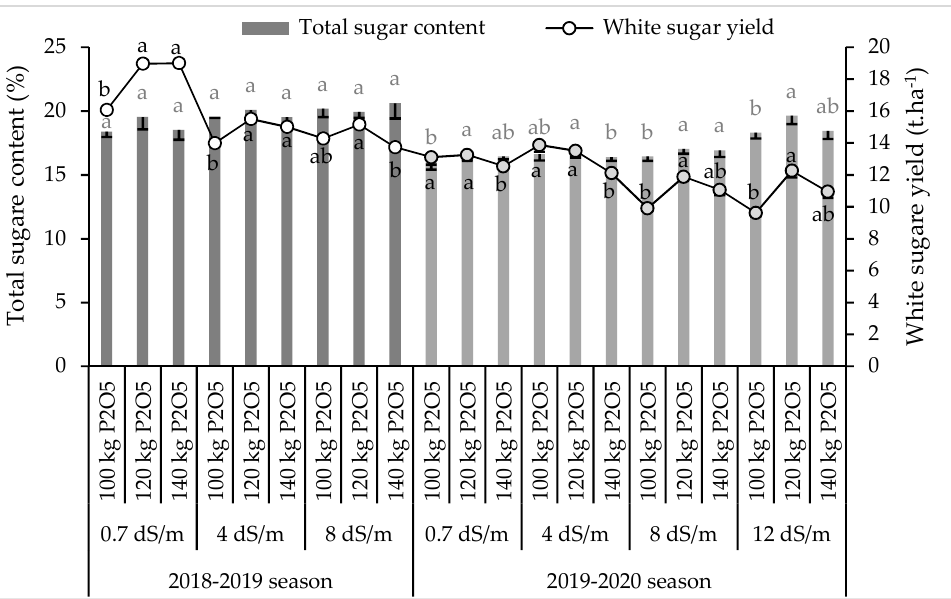
Figure 4. Variation of total sugar content and white sugar yield under different salinity levels and P applications. Error bars indicate the standard deviation. Phosphorus treatments under the same salinity level without a common letter are significantly different at p < 0.05.